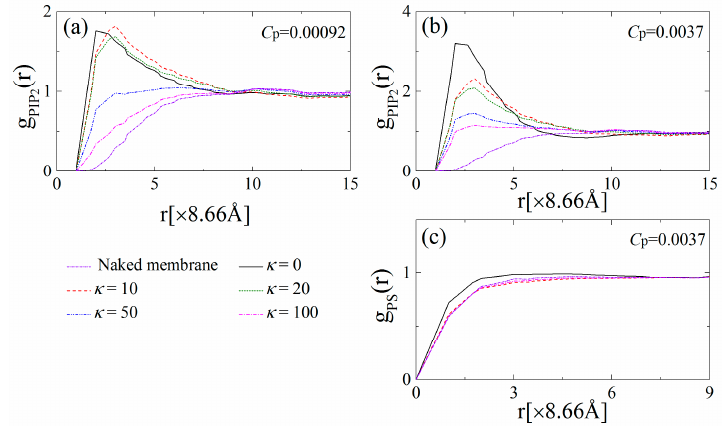
Figure 3. Radial distribution function of the PIP 2 lipids for ( a ) C p = 0.00092 and ( b ) C p = 0.0037 for various chain rigidity parameters κ ; ( c ) Radial distribution function of the PS lipids for C p = 0.0037. The results shown are for PC:PS:PIP 2 = 98:1:1.